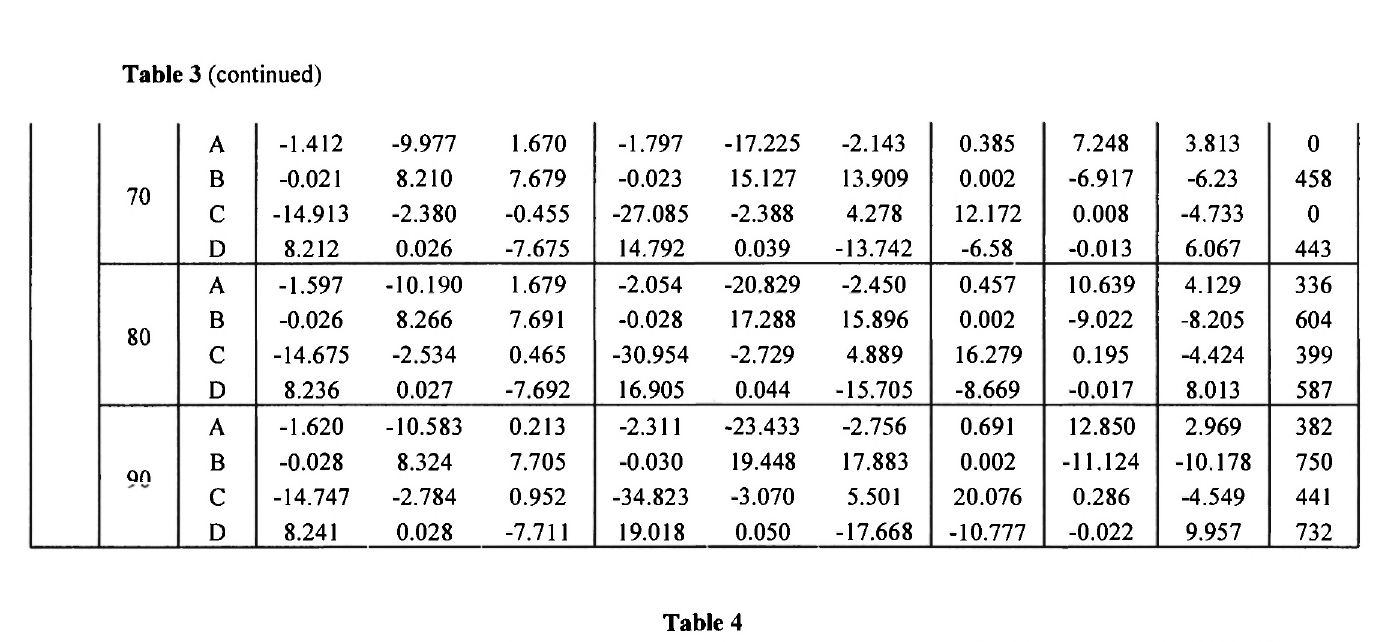
Maximum values of tensile elastic and elasto-plastic stresses for symmetric cross/ply [0°/90°] s and angle/ply